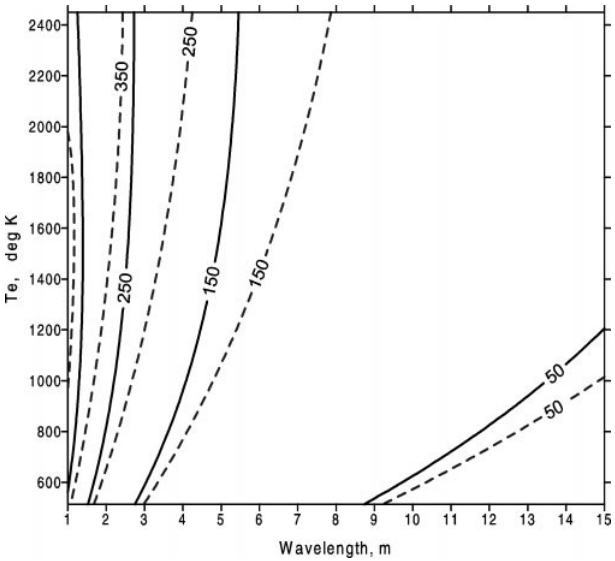
Fig. 5. Same as in Fig. 4, but for the growth rate divided by the wave number,